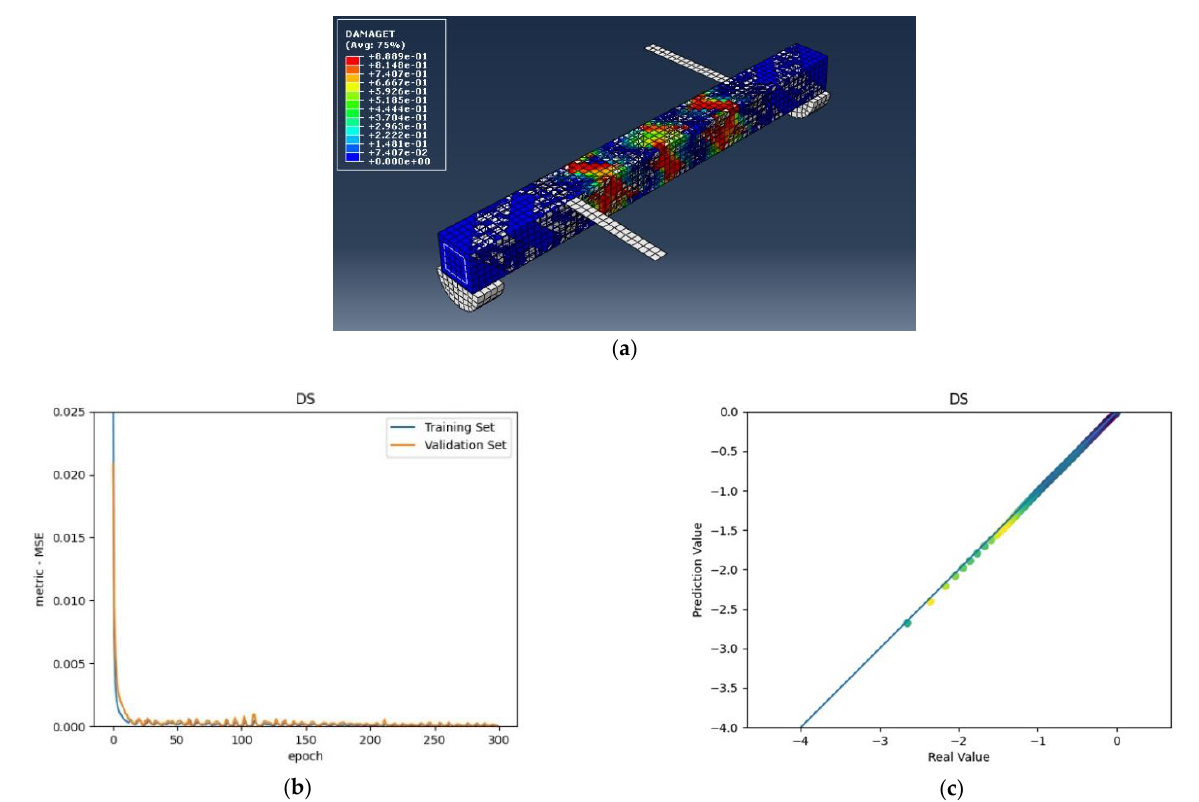
Figure 10. ( a ) DS beam under combined torsion and bending, ( b ) Training loss, ( c ) Accuracy.